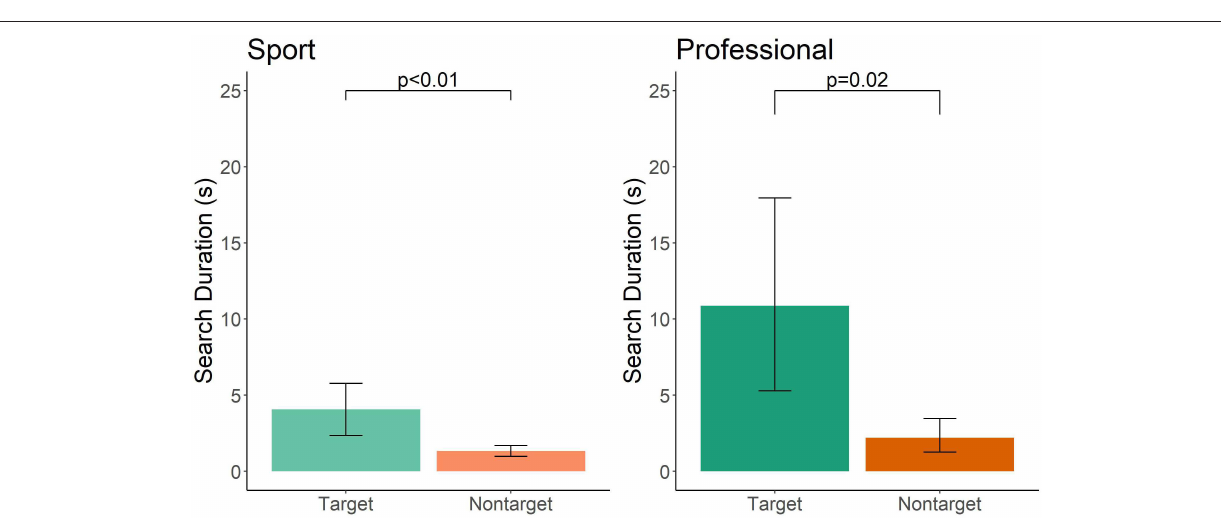
df = 55, p = 0.009; Figure 3 ). This effect was not associated with the frequency of double-blind training ( t = 0.201, df = 32, p = 0.84), frequency of blank training runs ( t = 1.617, df =